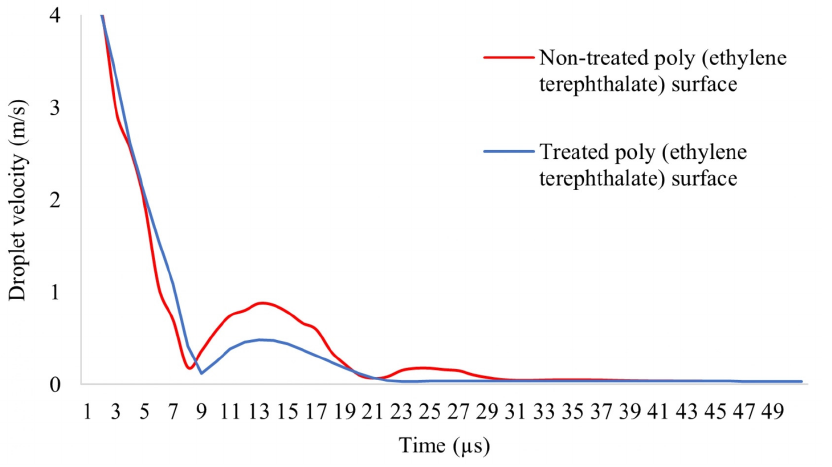
Figure 7. The change in inkjet droplet velocity on non-treated and treated poly (ethylene terephthalate) surfaces. late)